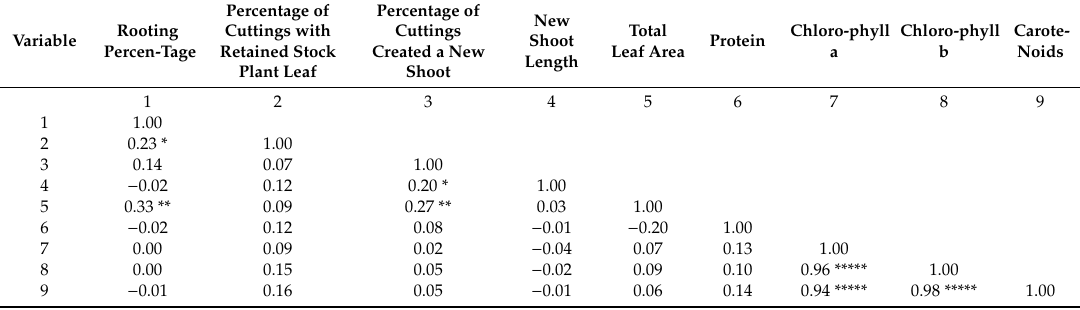
Table 5. Correlations matrices between rooting percentage and growth parameters, pigments, and soluble proteins content for cutting derived from shoots with flowers opened in Rosa ‘Maiden’s Blush’.